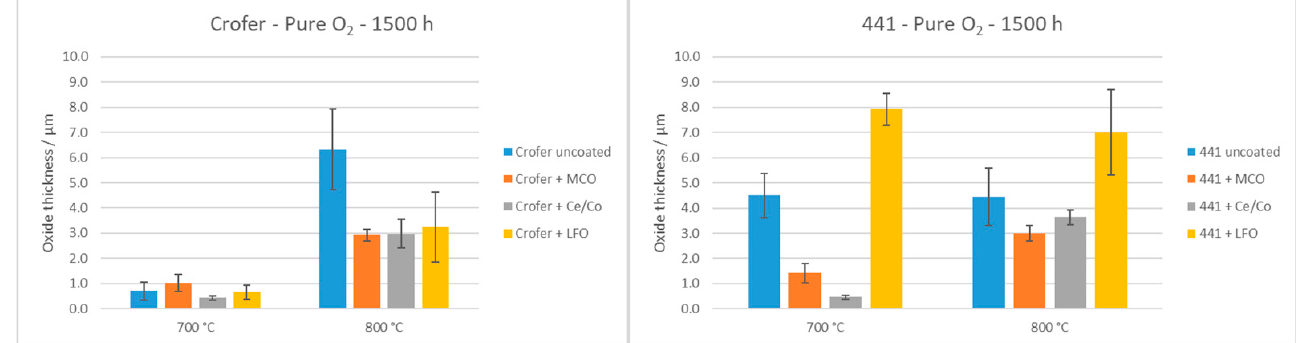
Figure 11. Average oxide scale thicknesses (including chromium-rich oxides) for Crofer 22 APU ( left ) and AISI 441 ( right ) samples tested in oxidizing atmosphere with standard deviations.